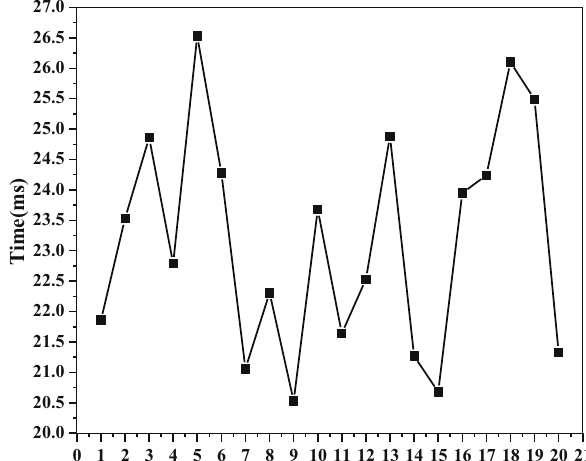
Figure 6: Time - consumption of Voronoi skeleton diagram method planning path algorithm.